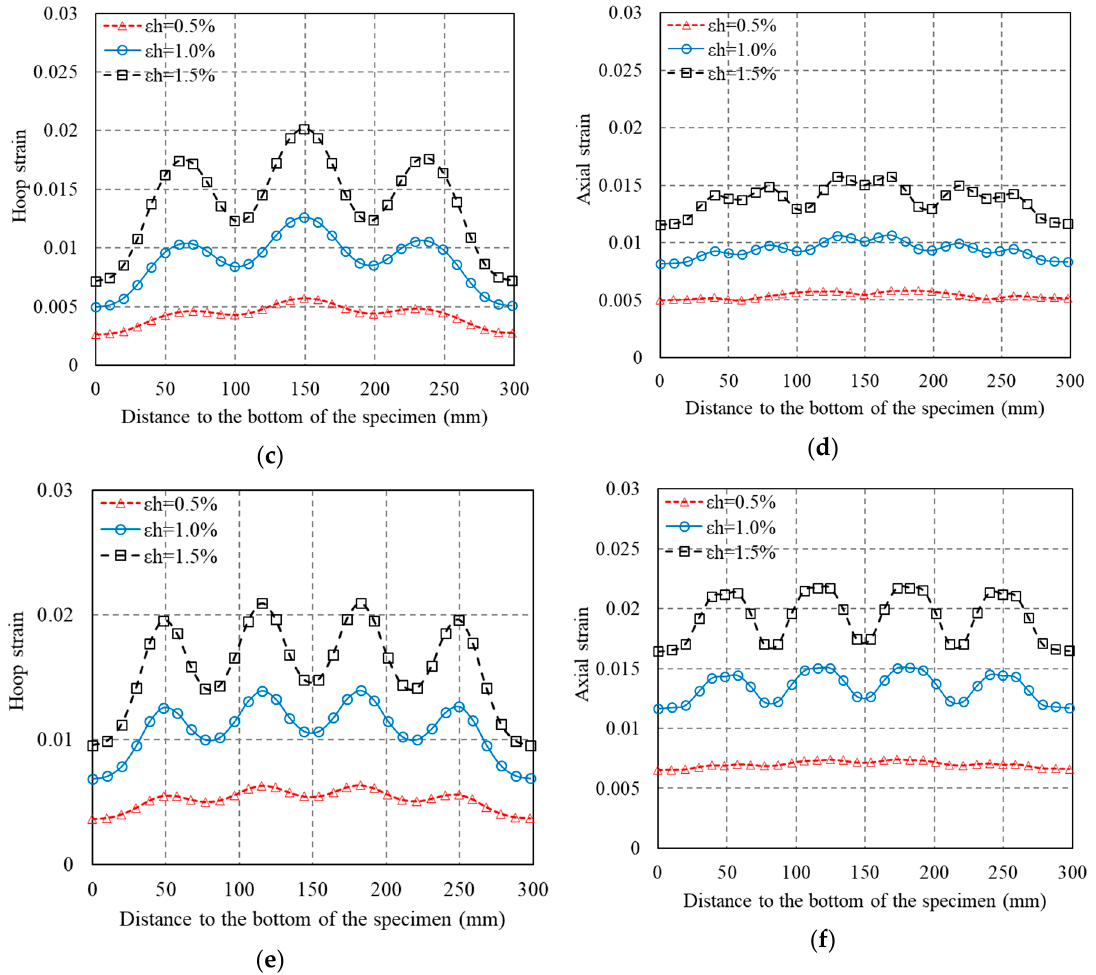
Figure 21. Axial strain and radial strain distribution along the generatrix (column height). ( a ) Hoop strain (S-2-3-30); ( b ) Axial strain (S-2-3-30); ( c ) Hoop strain (S-2-4-30); ( d ) Axial strain (S-2-4-30); ( e ) Hoop strain (S-2-5-30); ( f ) Axial strain (S-2-5-30).